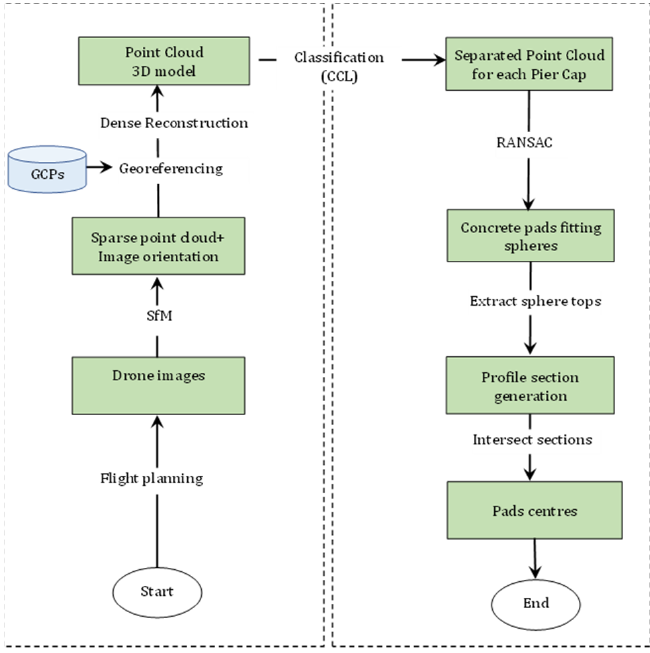
Figure 2. The workflow of the proposed method.